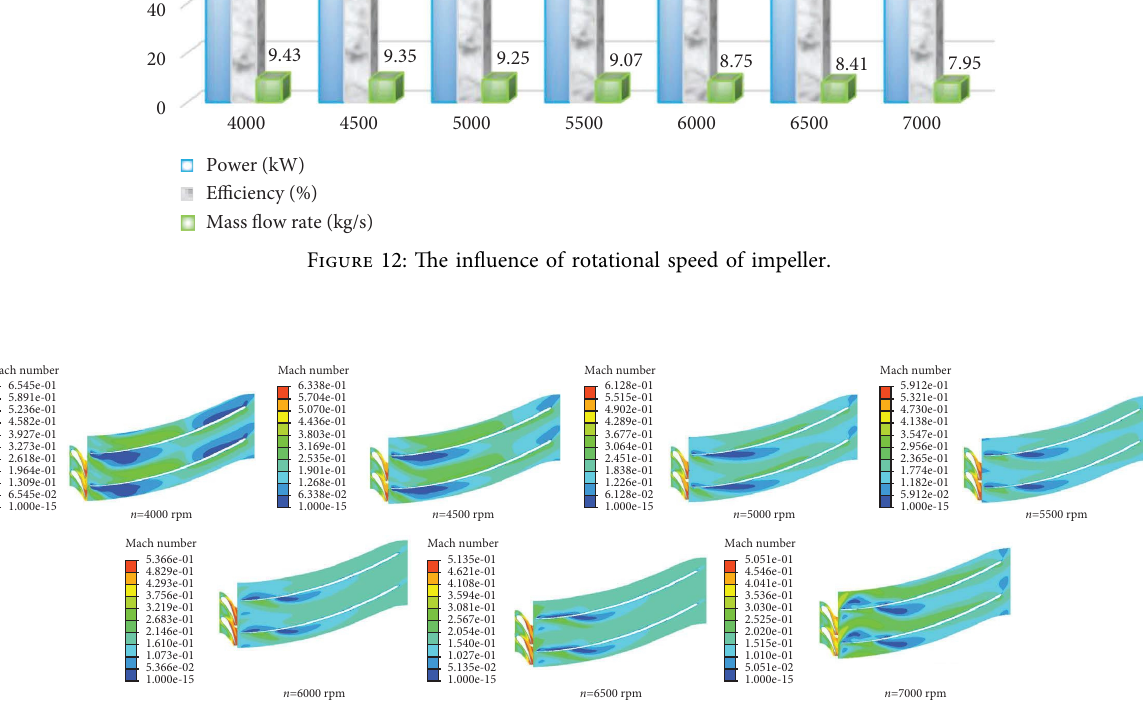
Figure 13: Distribution of Mach number at the half blade height with rotational speed of